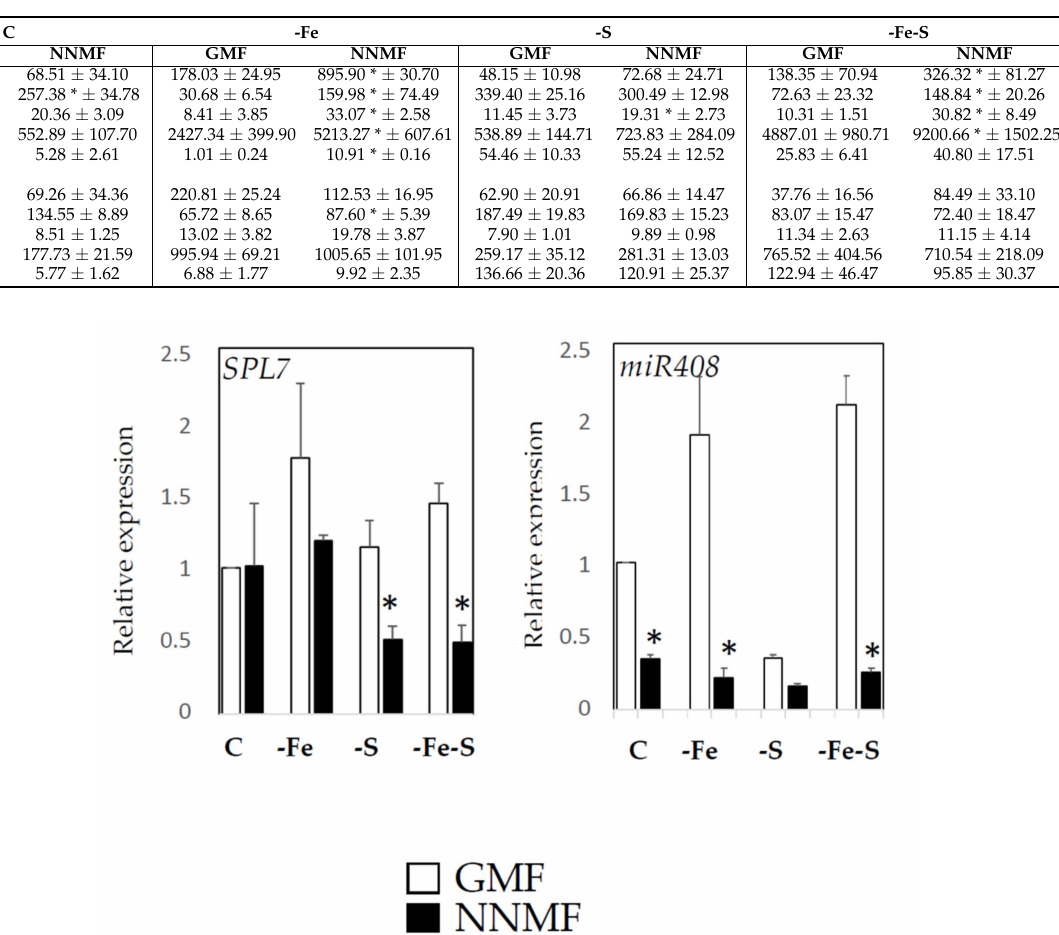
Table 1. Metal contents (Fe, Zn, Cu, Mn, and Mo expressed as µ g/g dry weight) of shoot and root tissues of Arabidopsis thaliana seedlings exposed to GMF and NNMF and grown under full nutrient conditions (C), absence of iron (-Fe), absence of sulfur (-S), and combined Fe and S deficiency (-Fe-S). Data are shown as the mean ( ± SE) of four independent biological experiments; asterisks indicate significant ( p < 0.05) differences between NNMF and GMF exposed plants. Two-way ANOVA results are reported in Table S1.